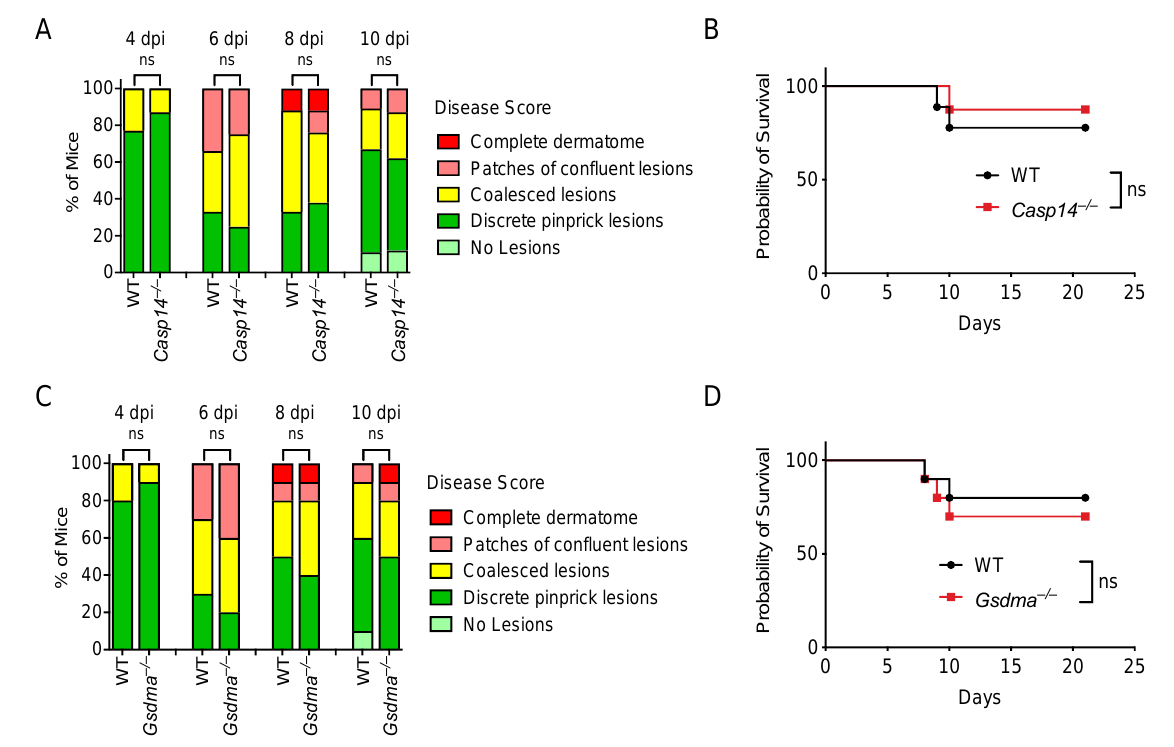
Figure 6. Caspase-14 and GSDMA are not required to control HSV-1 skin infection. Mice were infected on the right flank with 10 5 PFU HSV-1 strain NS. Disease scores ( A , C ) and survival ( B , D ) were monitored between WT and knockout mice. Mice number in: ( A , B ) WT n = 9, Casp14 –/– n = 8; ( C , D ) WT n = 10, Gsdma –/– n = 10. Data are pooled from two experiments ( A – D ). ns: not significant.